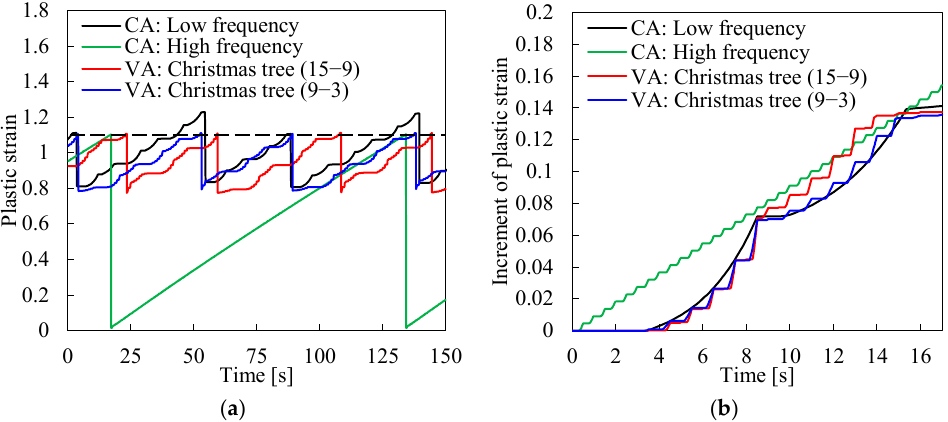
Figure 5. Comparison of different loading spectrums: ( a ) plastic strain evaluated at the node containing the crack tip; ( b ) increment in plastic strain evaluated at the node containing the crack tip.